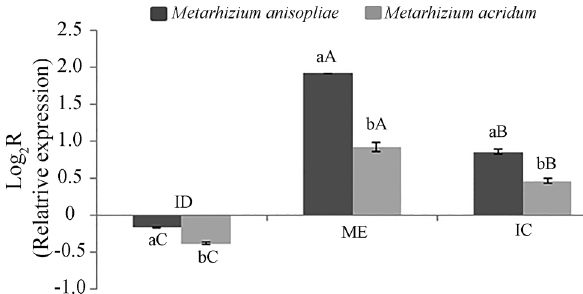
Figure 2 - Relative expression levels of pr 1A during pathogenesis of Metarhizium anisopliae and Metarhizium acridum . Means followed by distinctlettersdifferbytheTukeytestat5%probability;lower-caseletters represent differences between isolates at each phase, and upper-case let- ters represent the differences between phases for each isolate. ID = dead infected insect; ME = emergent mycelia from insect cadavers; IC = insect cadavers completely covered with